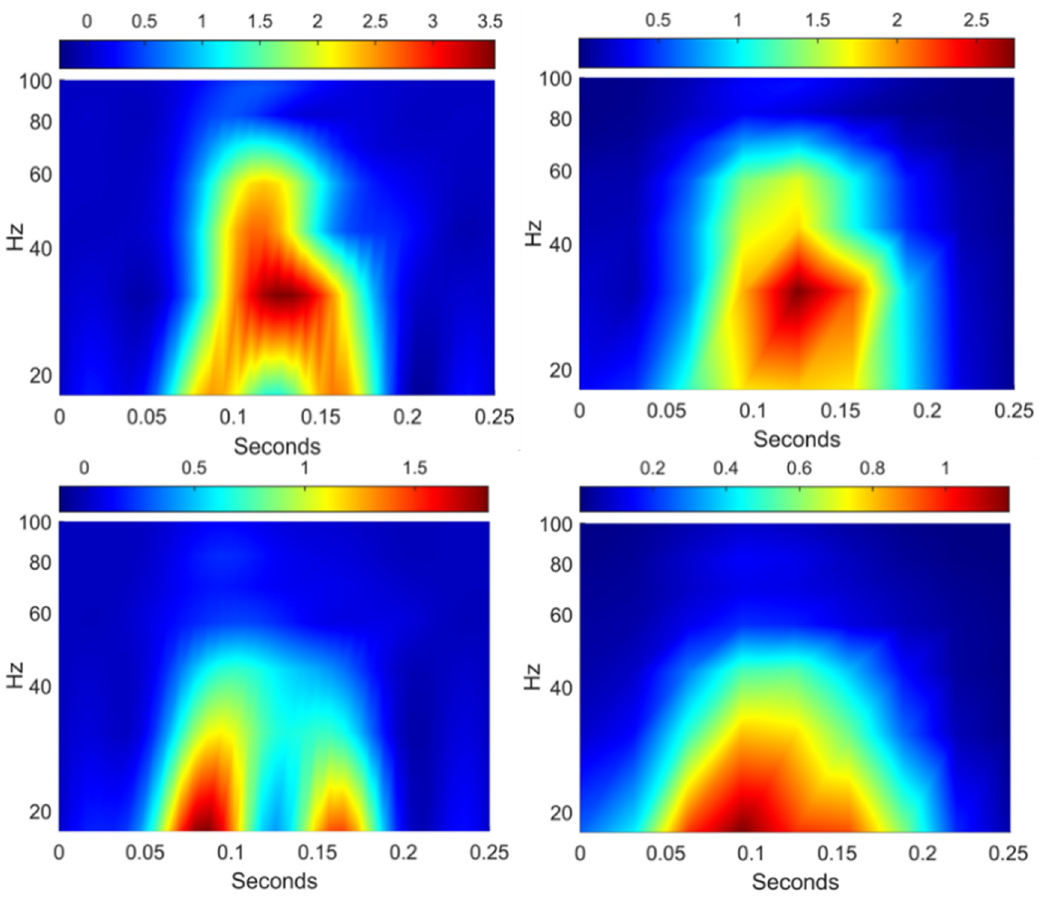
Figure 10. Wavelet scattering scattergrams ( right column ) and scalograms ( left column ) of the void 3 mm ( top row ) and the equivalent geometric ( bottom row ) irregularities.